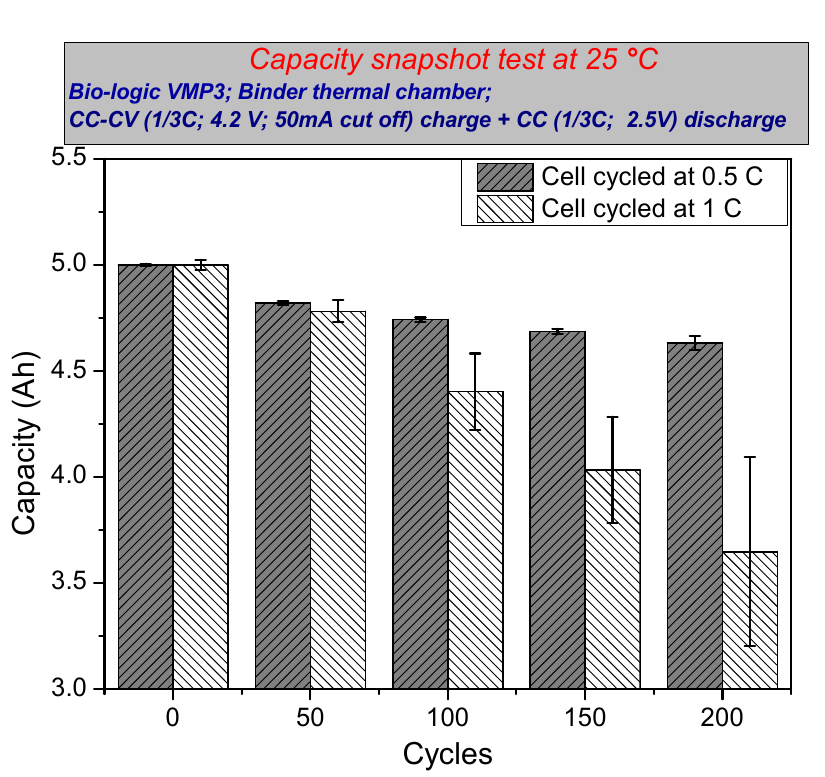
Figure A2. Capacity snapshot tested at 25 °C and 1/3 C for batteries that experienced 25 °C cyclings under the current rates of 0.5 C and 1 C.